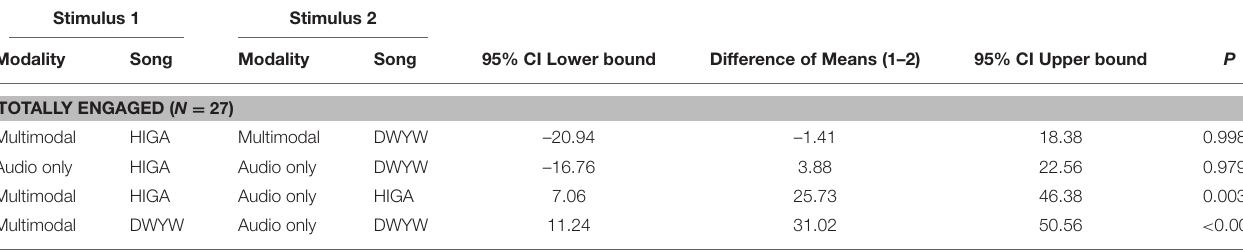
TABLE 3 | Comparison of subjective responses elicited by each musical stimulus derived from OK Go music videos. Stimulus 1 Stimulus 2